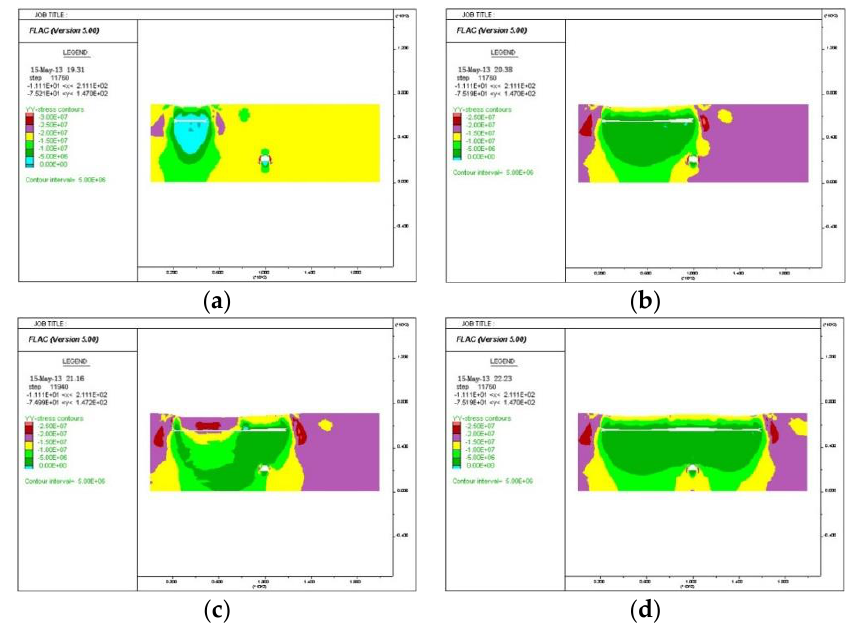
Figure 18. Vertical stress distribution of surrounding rock of roadway supported by anchor–shotcreting–grouting support. ( a ) Working face is 60 m away from the roadway. ( b ) Working face is 0 m away from the roadway. ( c ) Working face spans the roadway 20 m. ( d ) Working face spans the roadway 60 m.